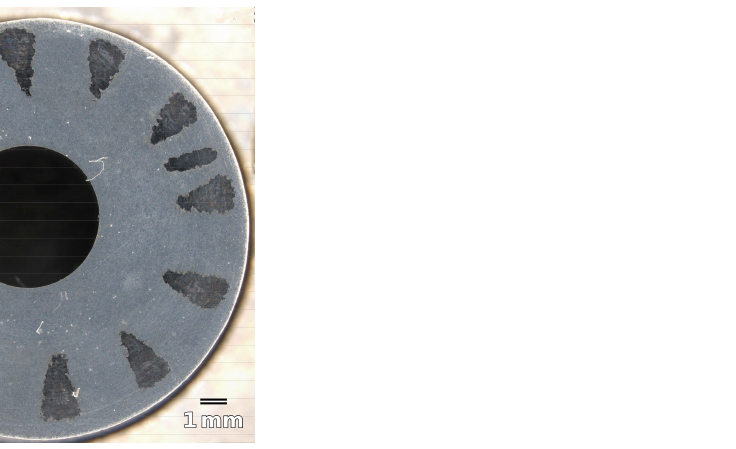
Figure 2. Solid-reagent pyrolysis LTNC-treated AM-annealed Alloy 22 sample with patches of dark film remaining after preliminary CCT testing.